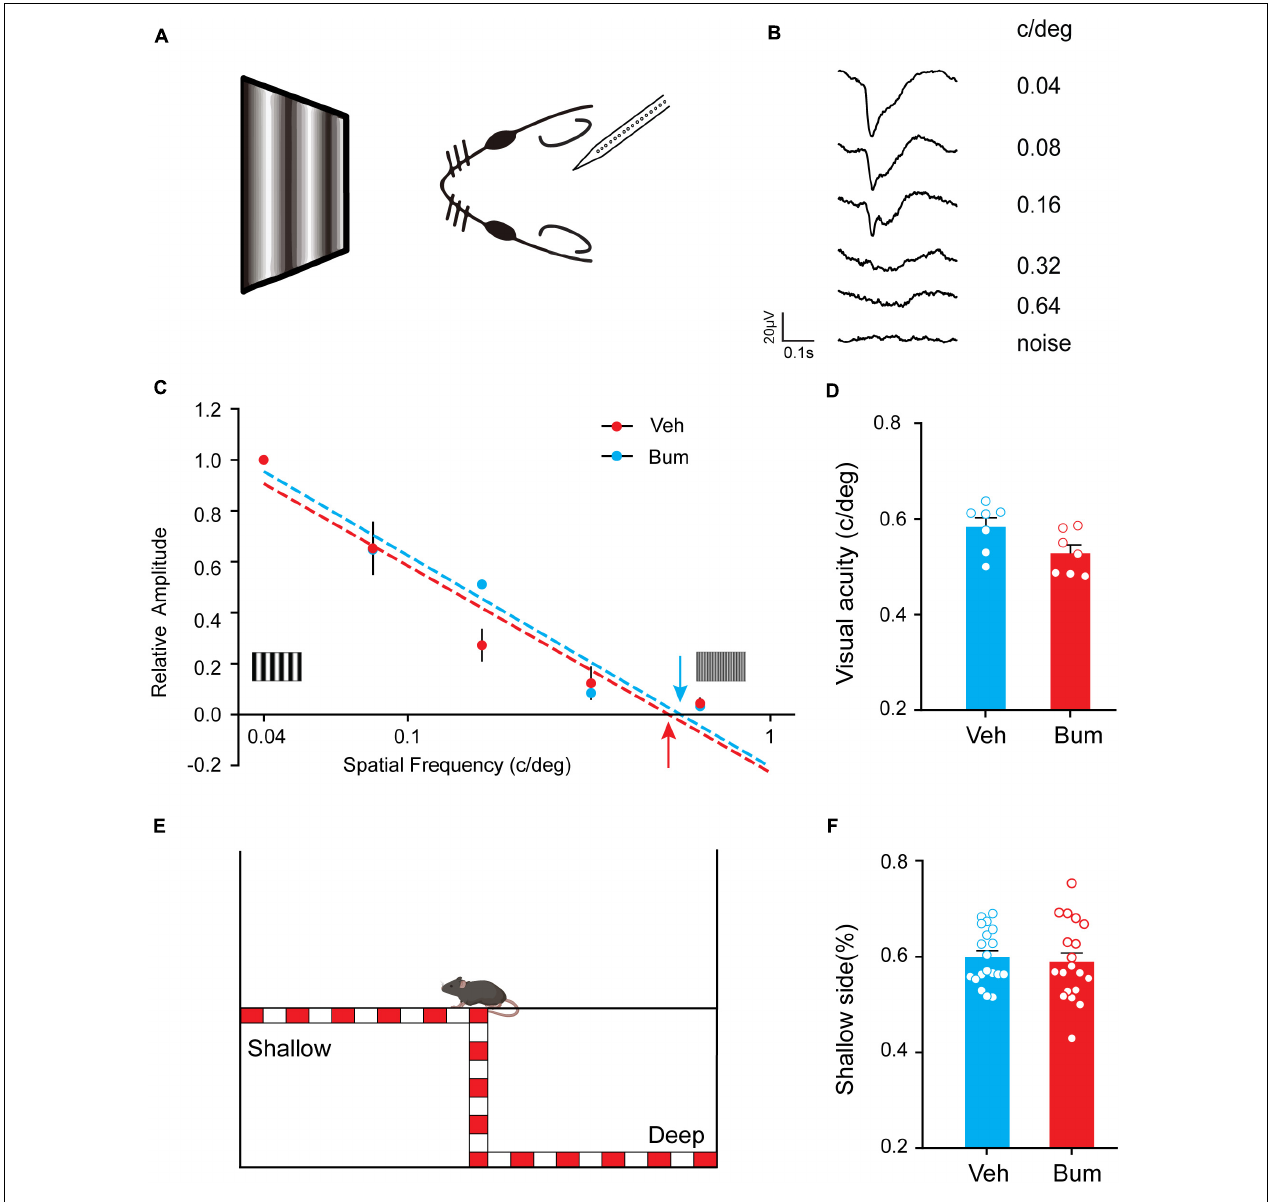
FIGURE 4 | Bum mice displayed normal visual acuity and depth perception. (A) Experimental paradigm. With increasing spatial frequencies, visual evoked potential (VEP) decrease in amplitude and increase in latency. At.64 c/deg spatial frequency, VEPs are barely distinguishable from a response to a blank field (noise). (B) Representative example of VEPs in response to gratings of different spatial frequency (numbers to the right of tracings). (C) VEP amplitudes normalized to the mean amplitude at 0.04 c/deg; dashed lines are linear fits to the data, respectively. Estimated visual acuities (red and blue) are taken as the extrapolation to 0 level of the fitting lines for Bum (red) and Veh (blue) mice at P35. (D) Summary of visual acuity in two groups. Visual acuity of Bum animals (0.52 ± 0.016 c/deg, seven mice) is similar to Veh mice (0.58 ± 0.018 c/deg, seven mice, p = 0.053, unpaired t -test). (E) Schematic diagram of the visual cliff tests. (F) No difference was detected in the time fraction on the shallow side of arena between Bum (0.60 ± 0.013; mice = 19) and Veh (0.59 ± 0.018; mice = 19) animals at P35 (unpaired t -test, p = 0.68). Each circle indicates individual mouse. Data were expressed as mean ±